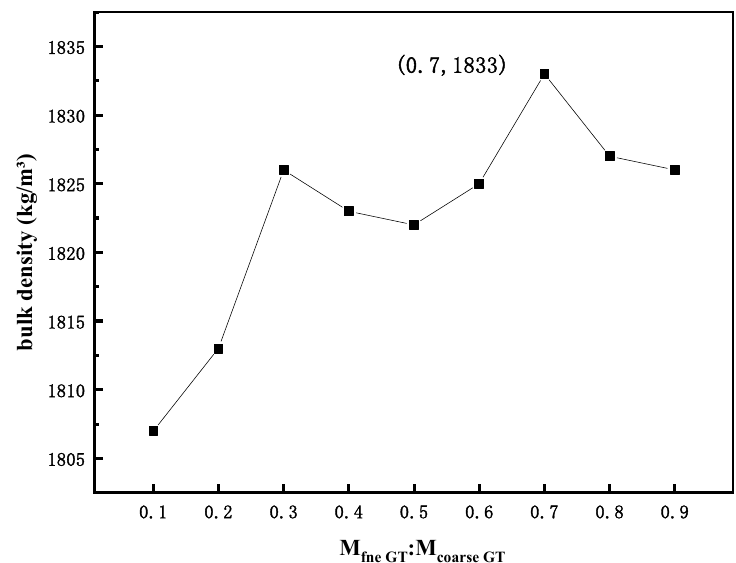
Figure 2. Bulk density test of sand.